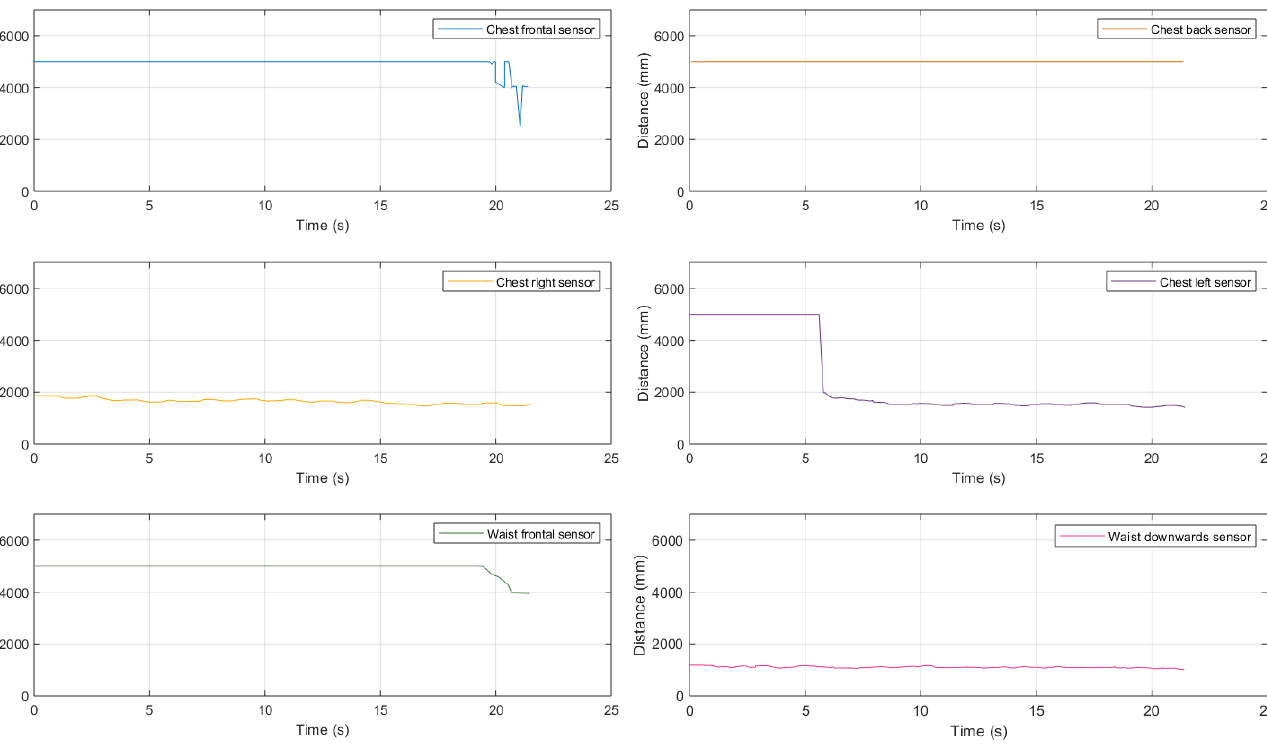
Figure 18. Experimental distance estimates obtained with the configuration shown in Figure 17 during a walk in the backyard of the house, and in the absence of